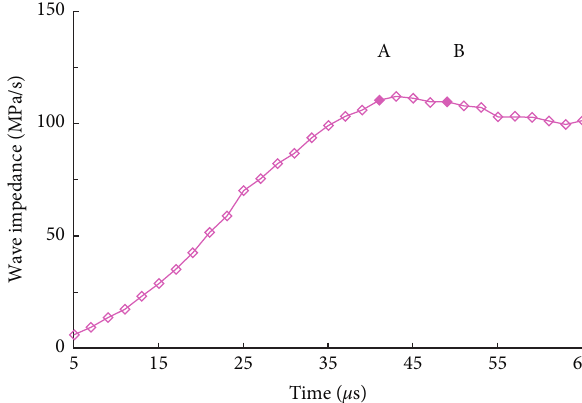
Figure 3: The trend of the wave impedance of the specimen over time.